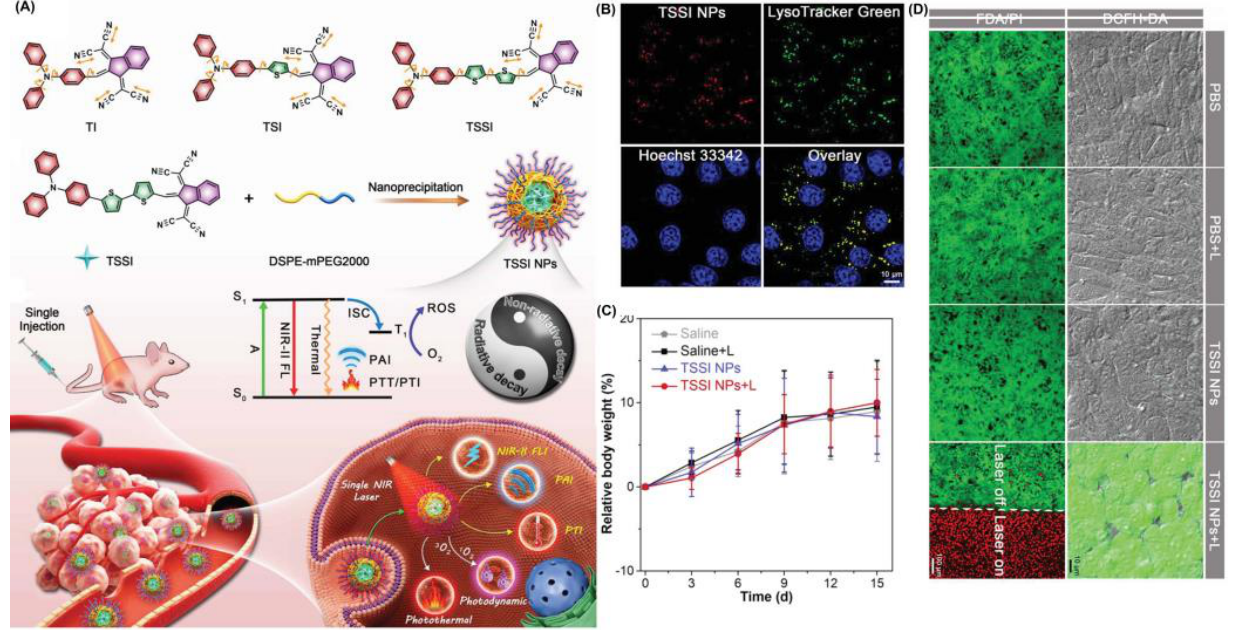
Figure 6. ( A ) Schematic illustration of mechanism and phototheranostic function of TSSI; ( B ) co- localization of 4T1 cells after incubation with TSSI NPs; ( C ) body weight changes of mice in vivo biosafety evaluation; ( D ) live/dead cell staining and intracellular ROS of 4T1 cells. Reprinted with permission from Ref. [70]. Copyright 2020 WILEY-VCH.